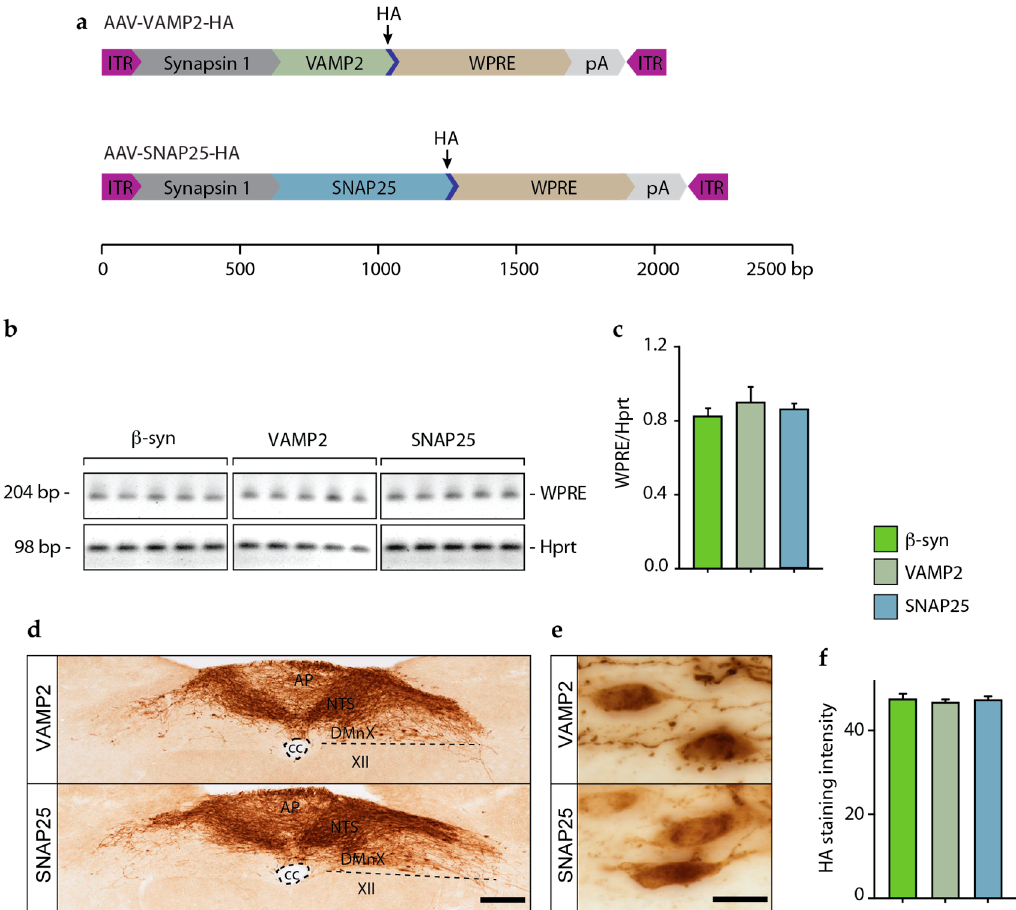
Figure 3. AAV-induced expression of β -syn, VAMP2, and SNAP25 in the dMO. Mice received an intravagal injection of AAV- β -syn-HA, AAV-VAMP2-HA, or AAV-SNAP25-HA and were sacrificed 6 weeks after surgery. ( a ) Vector design of AAV-VAMP2-HA and AAV-SNAP25-HA. The scale bar displays the size (base pair, bp) of each genetic component. ( b , c ) Tissue samples of the dMO ipsilateral to the injection site were collected from mice treated with AAV- β -syn-HA, AAV-VAMP2-HA, or AAV-SNAP25-HA (n = 5/group). RT-PCR was performed to detect WPRE and the housekeeping gene Hprt. Specific bands were detected at 204 (WPRE) and 98 (Hprt) bp ( b ). Densitometric measurements of WPRE and Hprt band intensities were plotted as WPRE to Hprt ratio. ANOVA, F 2,12 = 0.46, p = 0.64 ( b ). ( d , e ) Representative images show medulla oblongata sections from mice injected with AAV-VAMP2-HA or AAV-SNAP25-HA that were stained with anti-HA ( d ). High magnification images show robust VAMP2 or SNAP25 expression within cell bodies of the DMnX ( e ). Scale bars: 200 μ m ( d ) and 20 μ m ( e ). ( f ) Intensity of HA labeling (arbitrary units) in the dMO ipsilateral to the side of AAV injection ANOVA, F 2,12 = 0.23, p = 0.80. Abbreviations: XII: nucleus of the hypoglossal nerve; AP: area postrema; cc: central canal; DMnX: dorsal motor nucleus of the vagus nerve; ITR: inverted terminal repeat; NTS: nucleus tractus solitarius; pA: polyA; WPRE: woodchuck hepatitis virus posttranscriptional regulatory element.